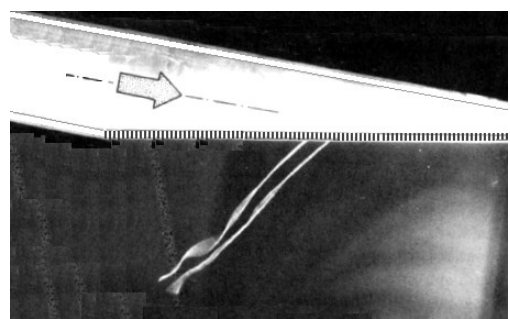
Fig. 10. Typical photograph of the measurements of the refraction angle  Z . The exit air flow was followed by two cotton threads with their upstream ends fixed to the cascade.